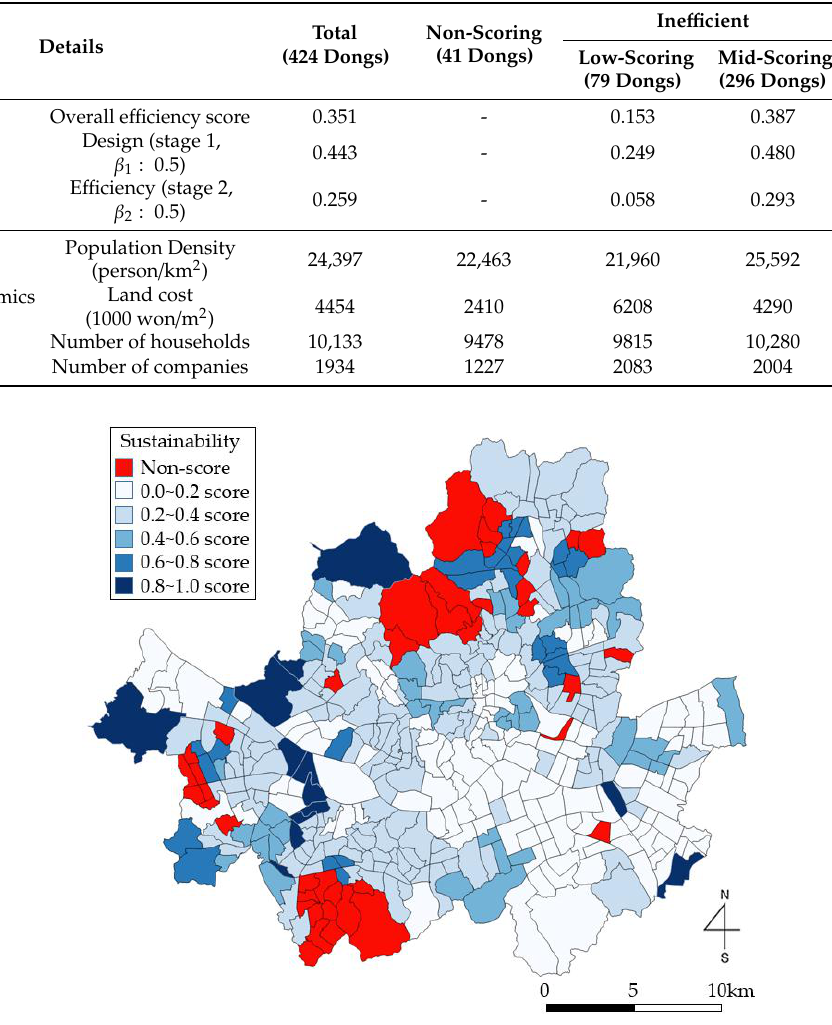
Figure 5. Visualization of the efficiency evaluation results by dong unit in Seoul.